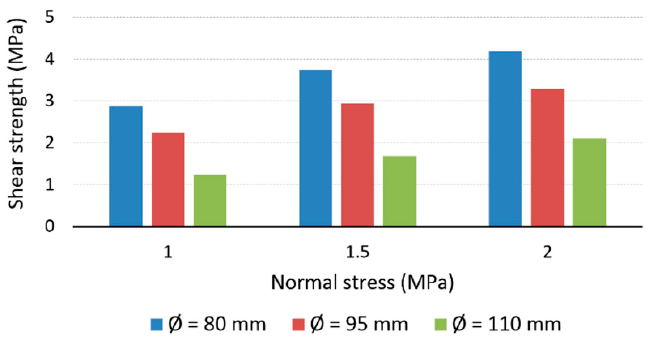
Figure 5. Shear strength of Br specimens (case I: σ J n = 0).